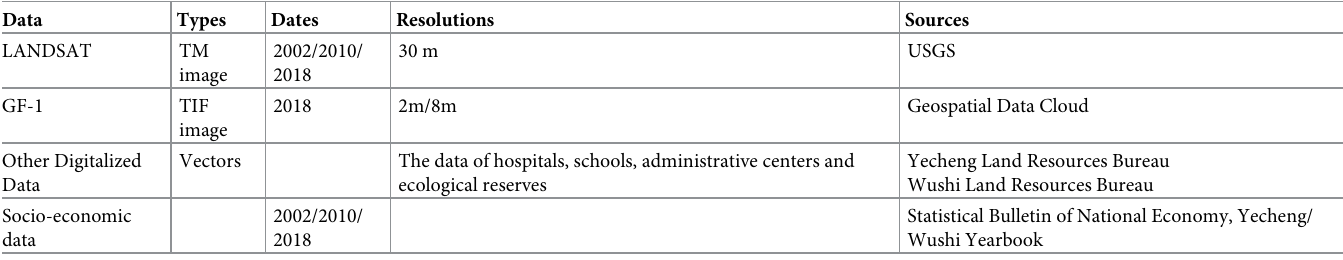
Table 1. Summary table of data source